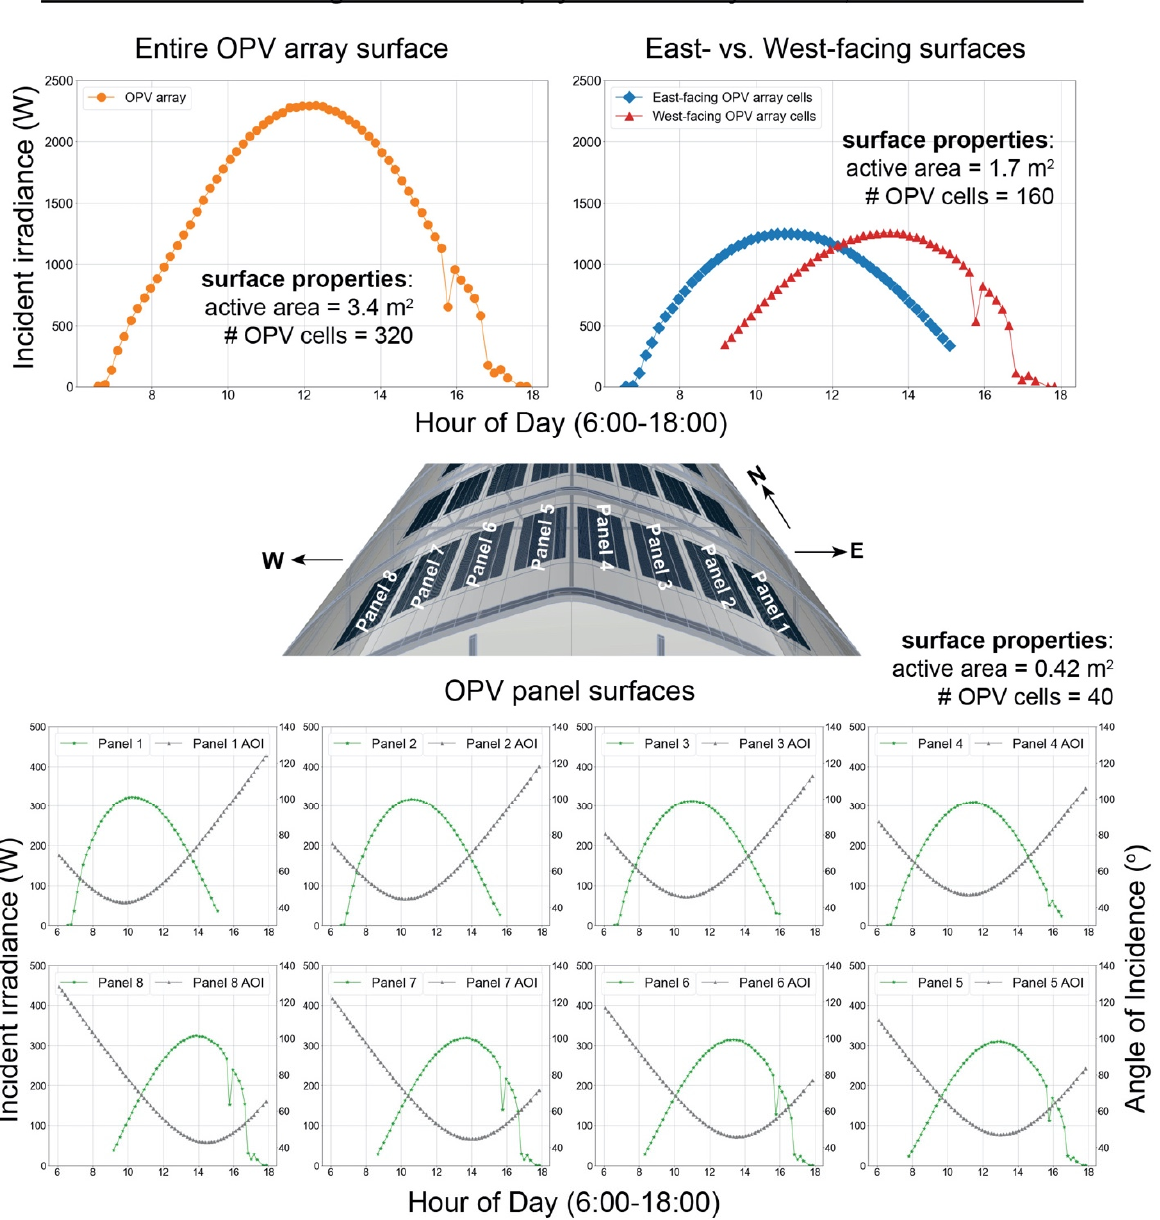
Figure 7. Modeled incident irradiance on the curved OPV array surface on the greenhouse for 4 November 2021 for different levels of spatial resolution; the angle of incidence (AOI) shown for the OPV panel surfaces represents the averaged AOI for the 40 cells belonging to each panel.